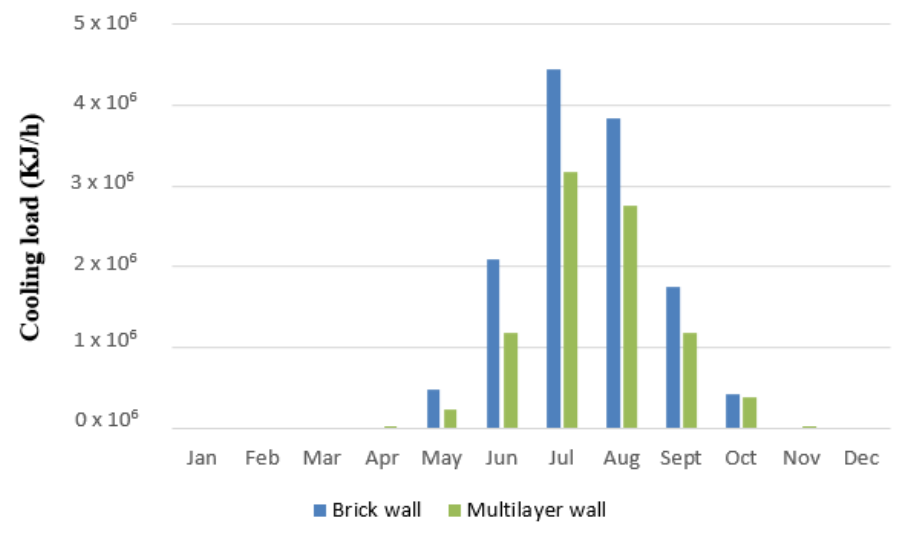
Figure 5. Monthly cooling needs for the simulated configurations.